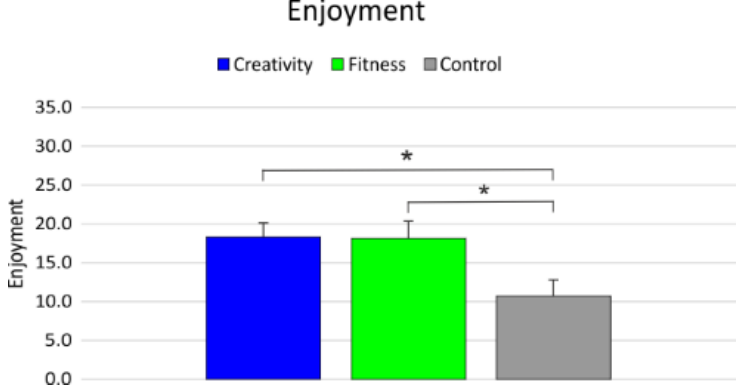
Figure 4. Degree of enjoyment. * significant differences. Table 4. Degree of enjoyment results.